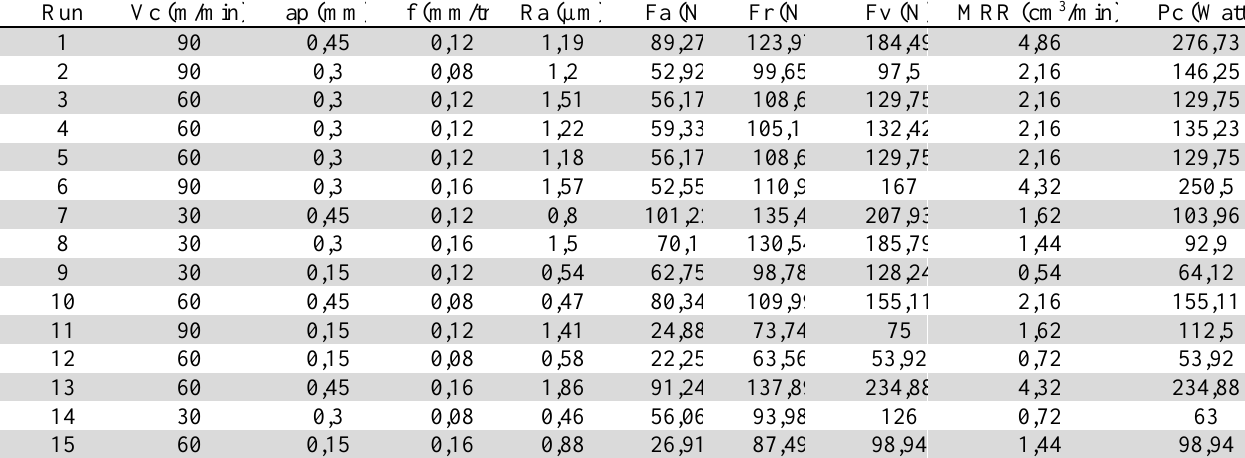
Experimental results for surface roughness, cutting force components, material removal rate and power consumption Run Vc